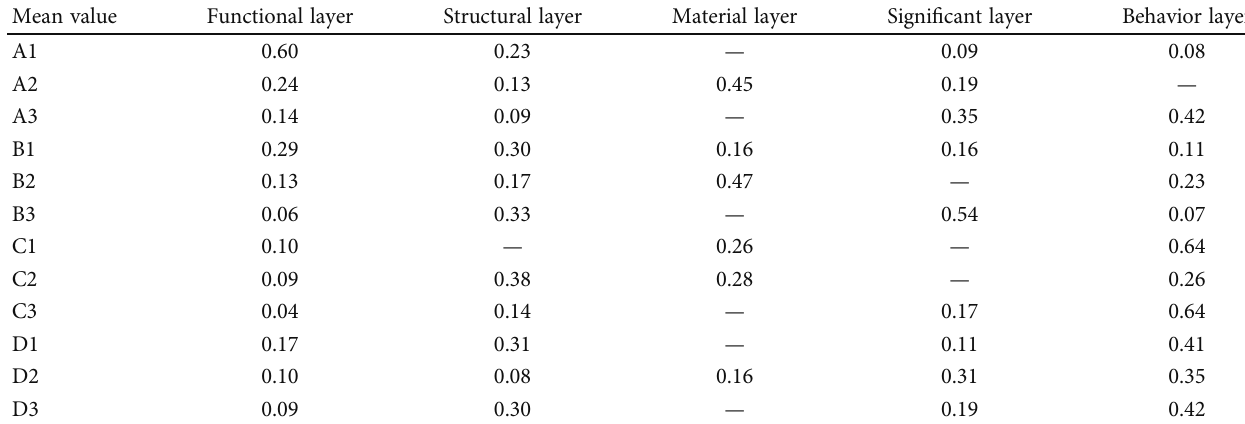
Table 4: The data collation of the appropriateness of each layer.